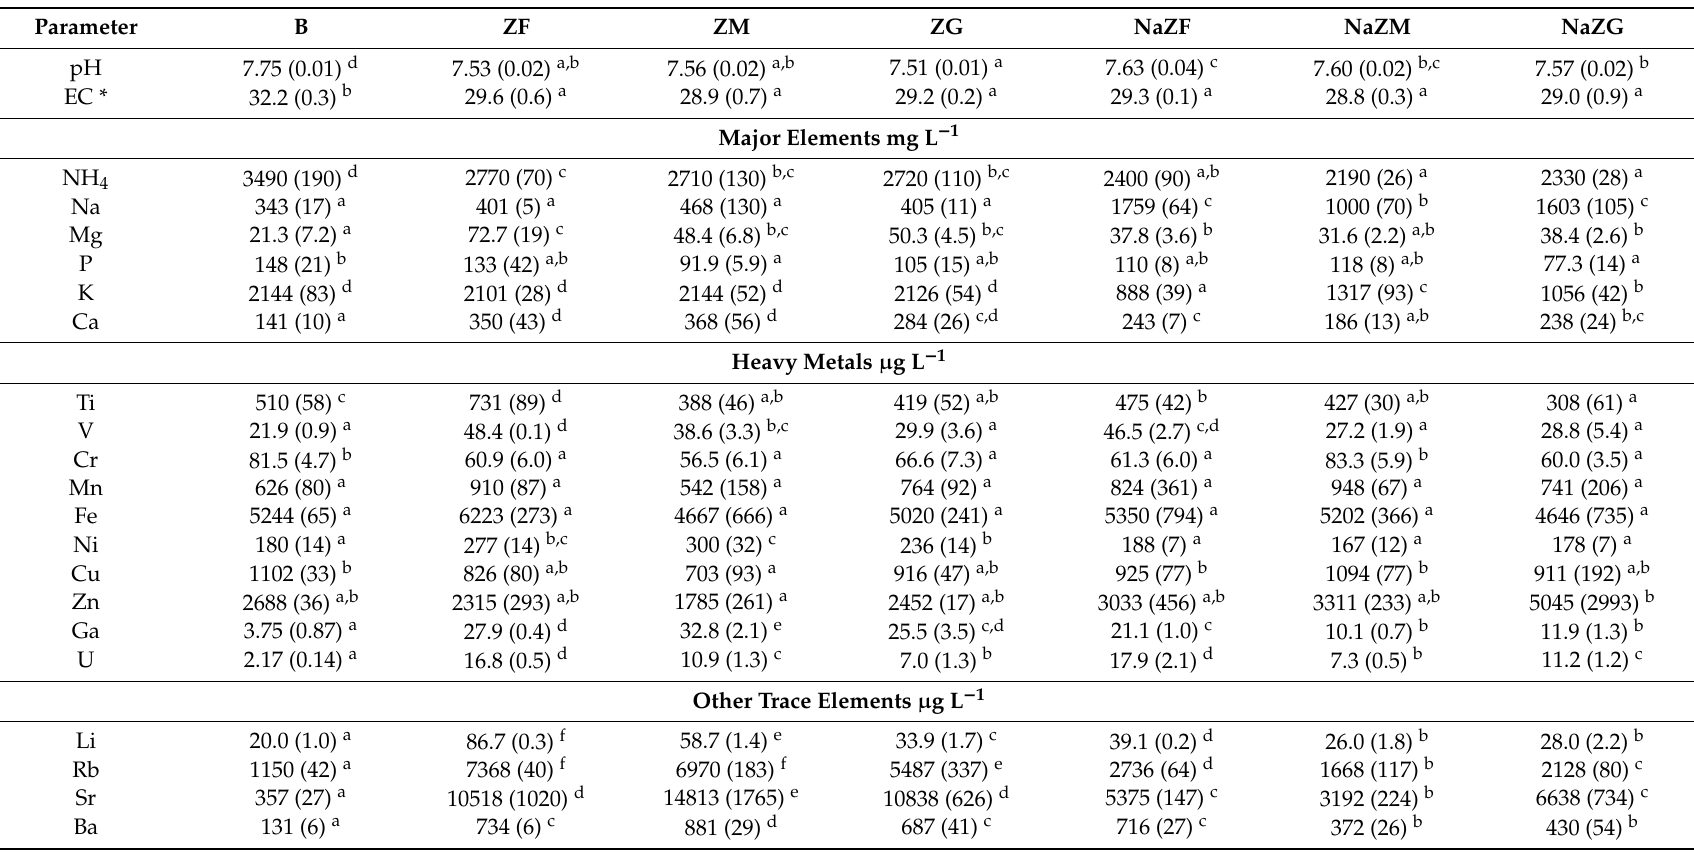
Table A2. Chemical composition of the studied pig-slurry (PS) after the second treatment cycle with natural ZTs (ZF, ZM, and ZG) and Na-exchanged ZTs (NaZF, NaZM, and NaZG) and in blank samples (without ZTs, B). Standard deviation within brackets (three replicates). Di ff erent letters (a,b,c,d,e,f) indicate significant di ff erences obtained from ANOVA and Tukey HSD tests. * Electrical conductivity is reported in mS cm − 1